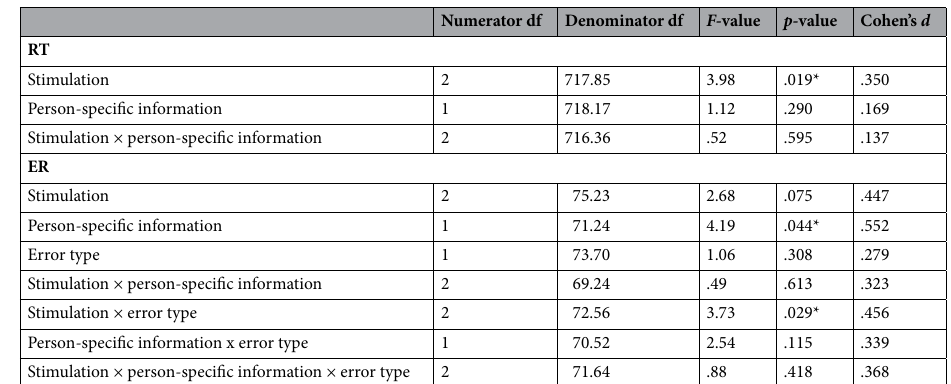
Table 2. Results of the linear mixed model (LMM) performed on the reaction times (RTs) and error rates (ERs) in Experiment 2. In the model, each participant was treated as a random factor (random intercept model). The within-subjects factors stimulation (anodal, cathodal and sham) and person-specific information (surnames, professions) were treated as fixed-effect covariates for the RT model. The within-subject factor error type was added to the model of the ER. Asterisks indicate significant results ( p < 0.05). df, Degrees of